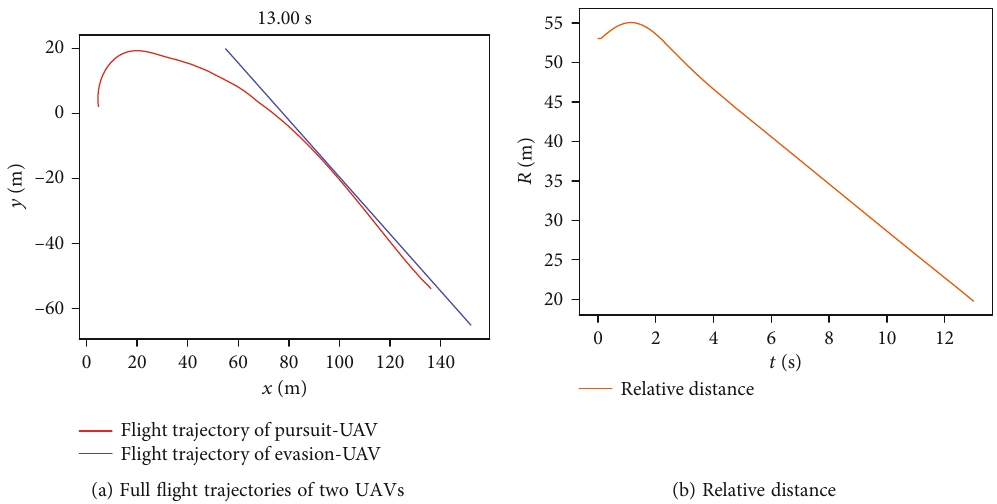
Figure 11: Flight trajectories and test results using IL-DDPG.